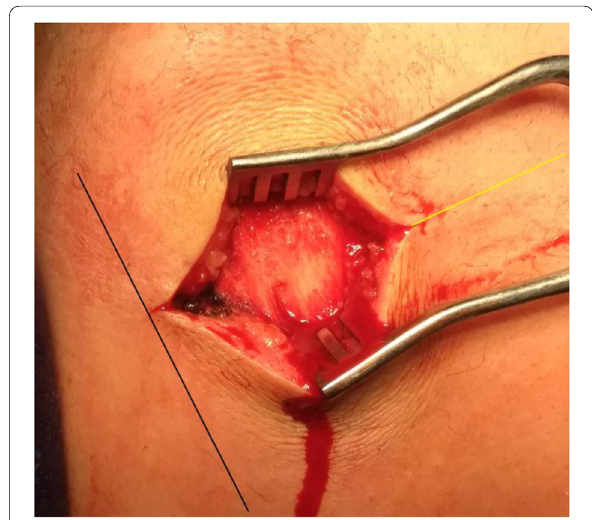
Fig. 6 demonstrates skin incision for approaching medial portion of the middle trapezius insertion tendon in the right shoulder. Starting from the black line‑marked medial scapular border and extending laterally for a distance of 5‑6 cm, the skin overlying medial half of the yellow line‑marked scapular spine is horizontally incised